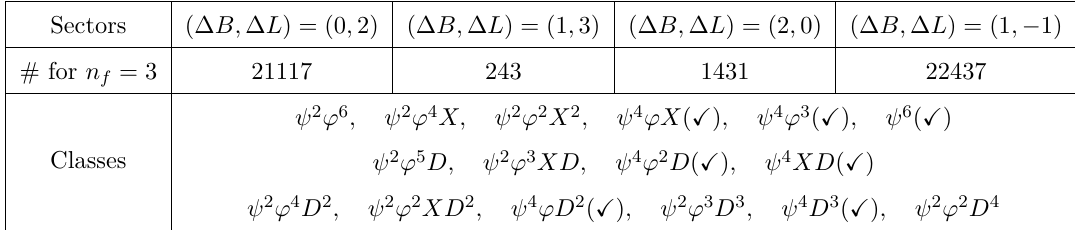
Table 1 . Dim-9 operators fall into various sectors and classes according to their lepton and baryon numbers and their field configurations, with the number of independent operators shown for each sector with three generations of fermions. Hermitian conjugates of operators are not